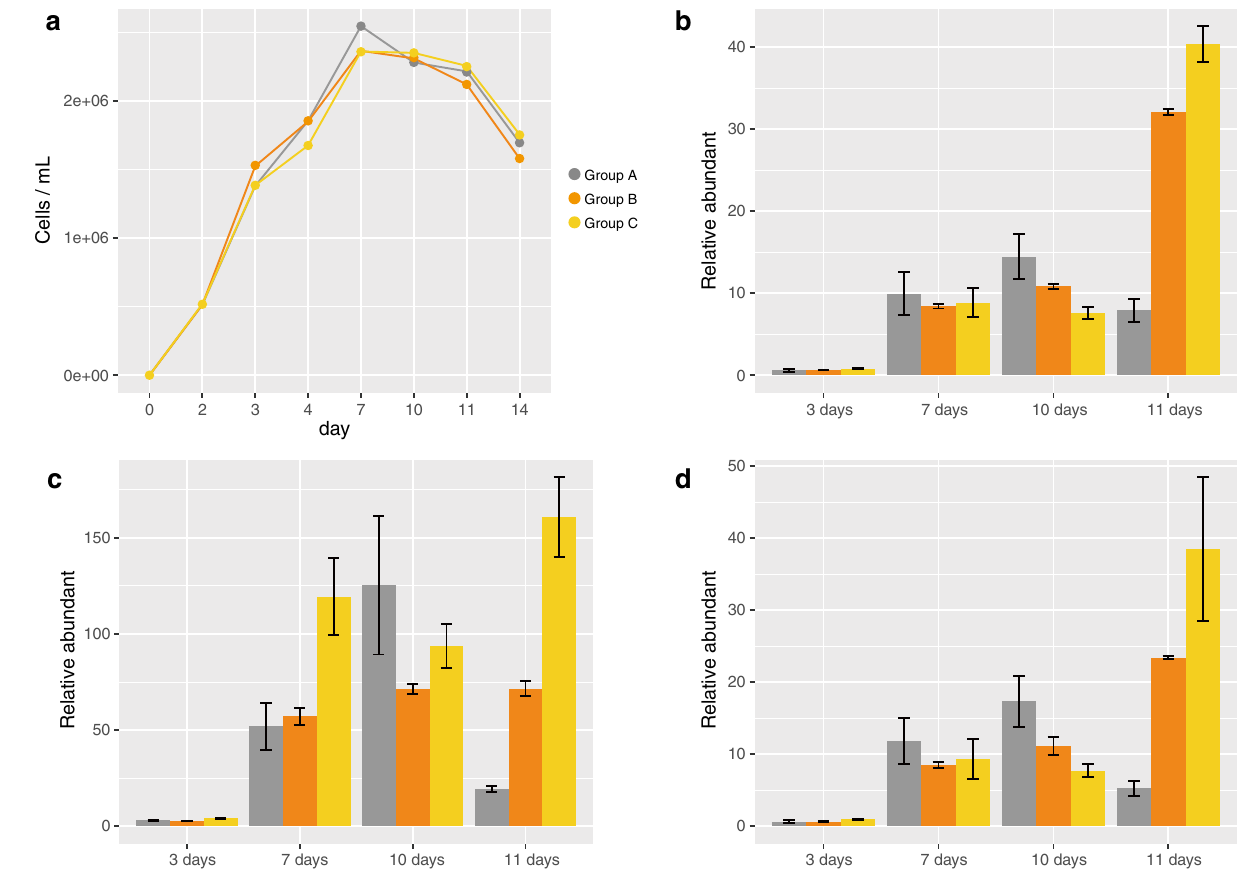
Figure 4. ( a ) Cell densities after 14 days of culture and the relative transcribe levels of the EVLF normalized by ( b ) actin , ( c ) gapdh , and ( d ) elongation factor . Cultures were performed in triplicate flasks (group a, b, c), and the line and bar colours in the plot correspond to the respective